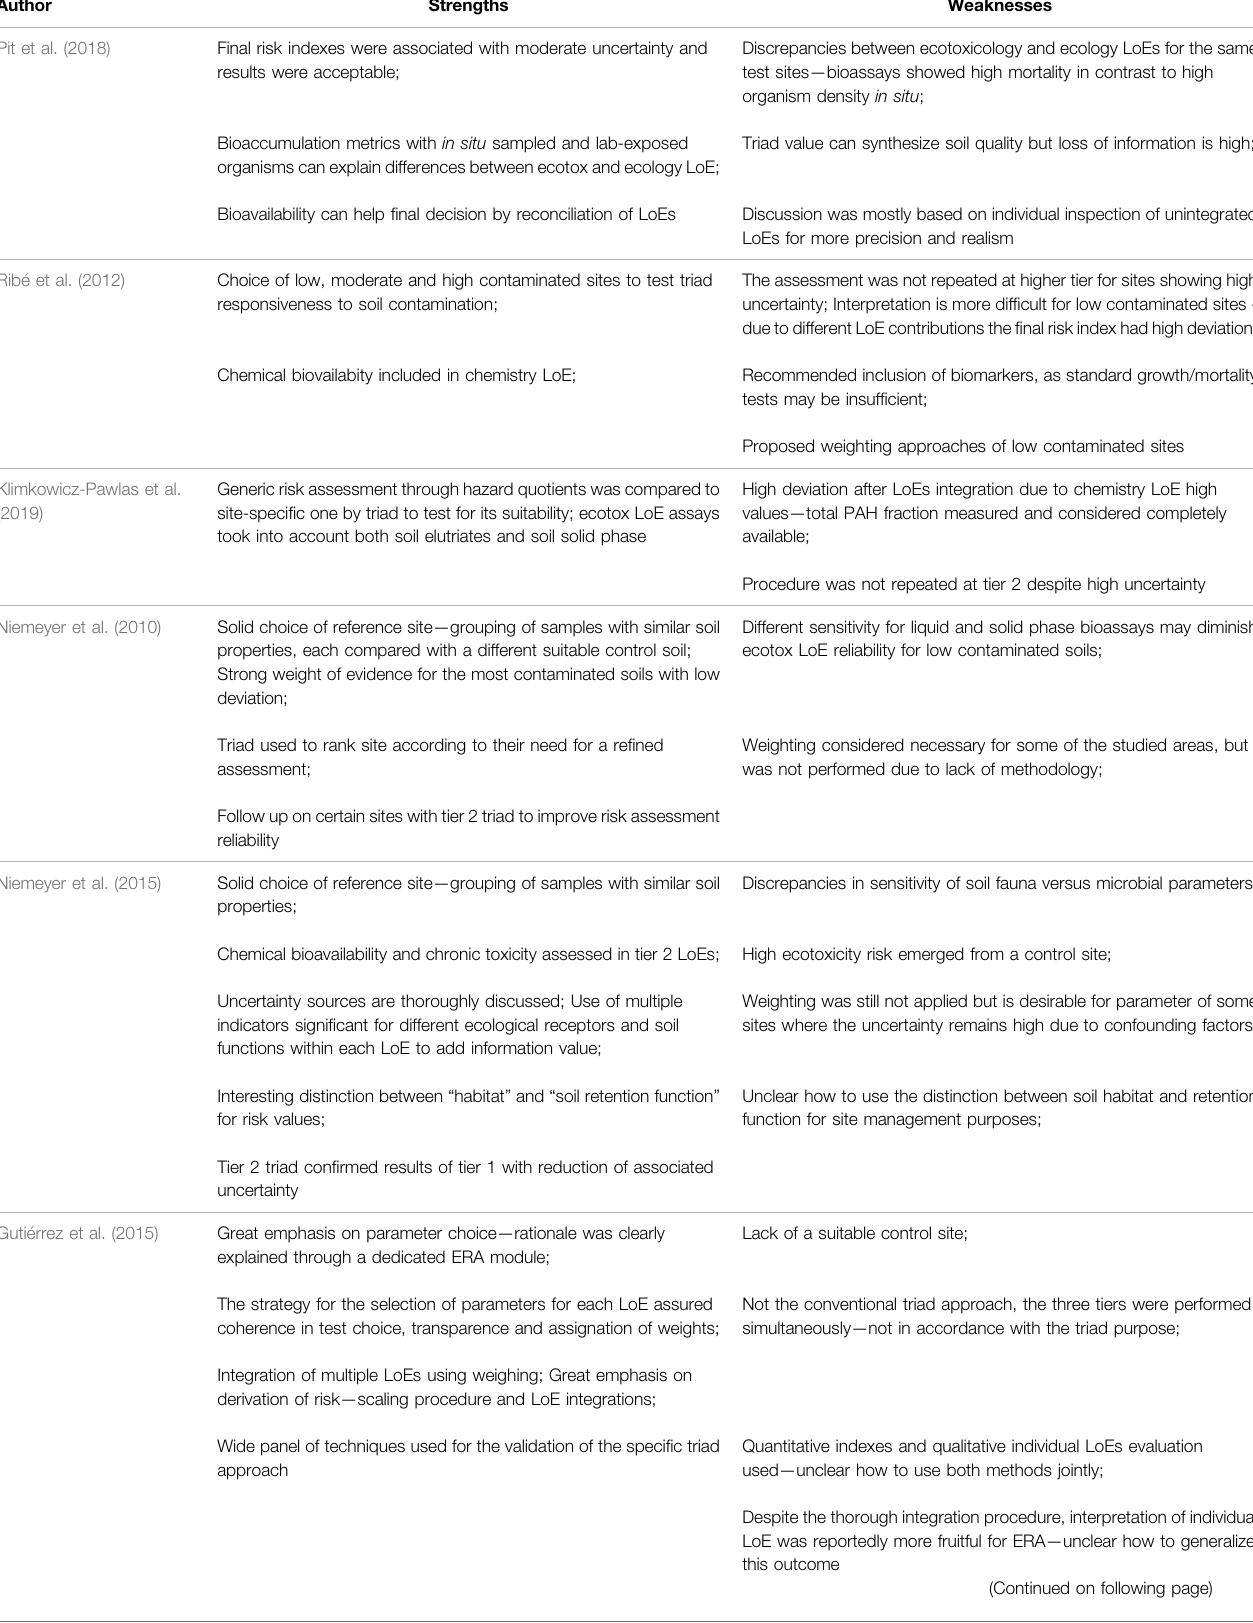
TABLE 2 | Main outcomes identi fi ed from analyzed literature. Each considered study was screened to evaluate the results of triad and summarize the strengths and weaknesseshighlightedbytheauthors,bothintermsofthequalityandsolidityoftheappliedprocedure,andofpossibledrawbacksthatcouldhamperriskassessment. Author Strengths